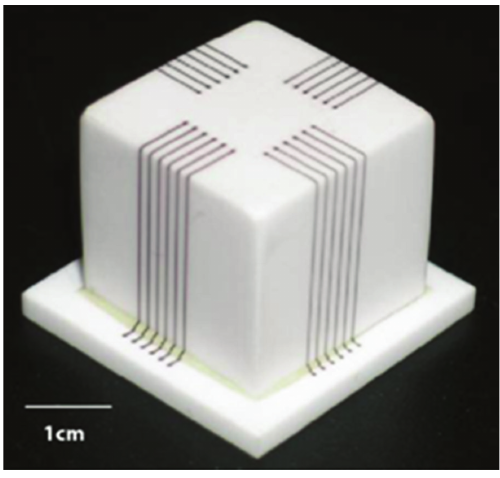
Figure 15: Aerosol Jet printed Ag traces, 150 μ m wide, on an alumina cube, from King and Renn [87], Copyright 2009 Optomec. Reprinted with permission.